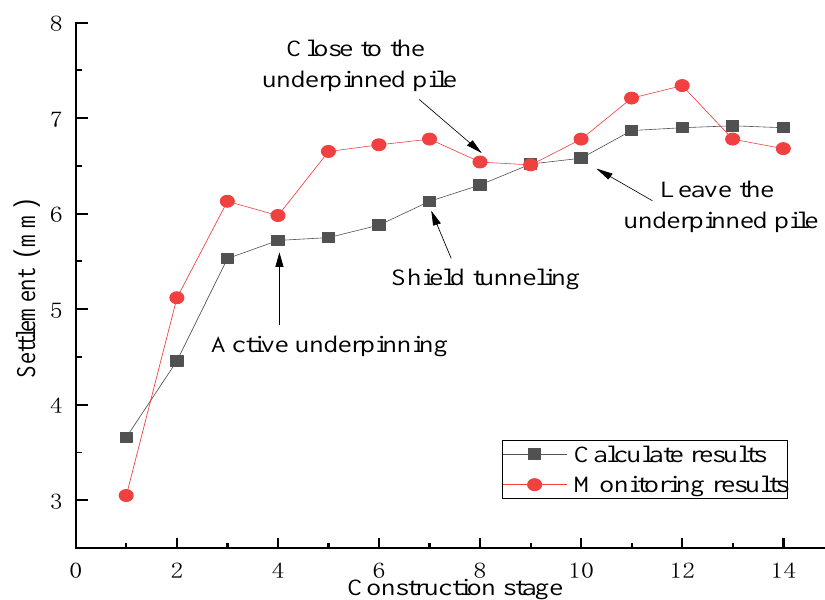
Figure 13. Vertical displacement results of the underpinning